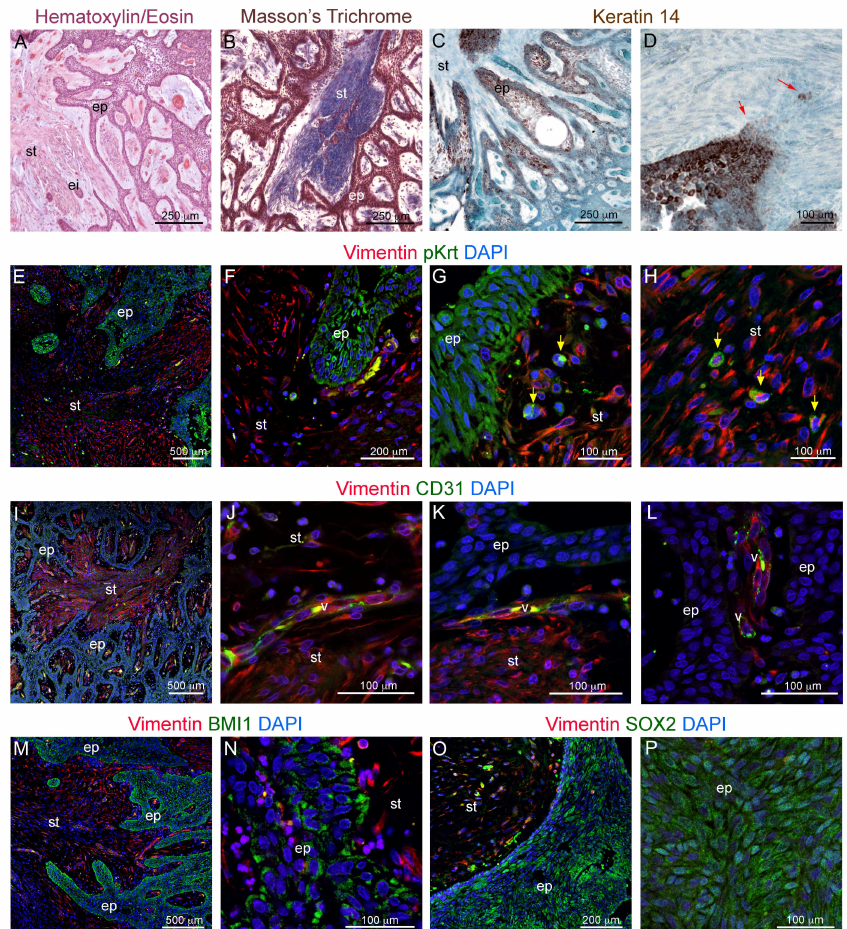
Figure 1. ( A ) Hematoxylin eosin staining of plexiform ameloblastoma. ( B ) Trichrome Masson’s Staining of plexiform ameloblastoma. ( C , D ) Immunohistochemical staining showing Keratin 14 (Krt14) distribution in ameloblastomas. Red arrowheads indicate Krt14 + cells invading the stroma. ( E – H ) Double immunofluorescent staining against the epithelial cell marker wide-spectrum-Keratin (pKrt; green color) and the mesenchymal cell marker Vimentin (red color). ( E ) Overview of epithelial and mesenchymal cells distribution. ( F , G ) Higher magnification of the epithelium / stroma interface. ( H ) Higher magnification of the stromal region, showing infiltration of pKrt + Vimentin + cells. Blue color: DAPI. Yellow arrowheads indicate pKrt + cells invading the stroma. ( I – L ) Double immunofluorescent staining against Vimentin (red color) and CD31 (green color). Blue color: DAPI. ( M , N ) Double immunofluorescent staining against BMI1 (green color) and Vimentin (red color). Blue color: DAPI. ( O , P ) Double immunofluorescent staining against SOX2 (green color) and Vimentin (red color). Blue color: DAPI. Abbreviations: ei, epithelial islet; ep, epithelium; Krt14, Keratin 14; pKrt, pan-Keratin; st, stroma; v, vessel. Scale bars: ( A – C ): 250 µ m; ( D , G , H , J – L , N , P ): 100 µ m; ( E , I , M ): 500 µ m; ( F , O ): 200 µ